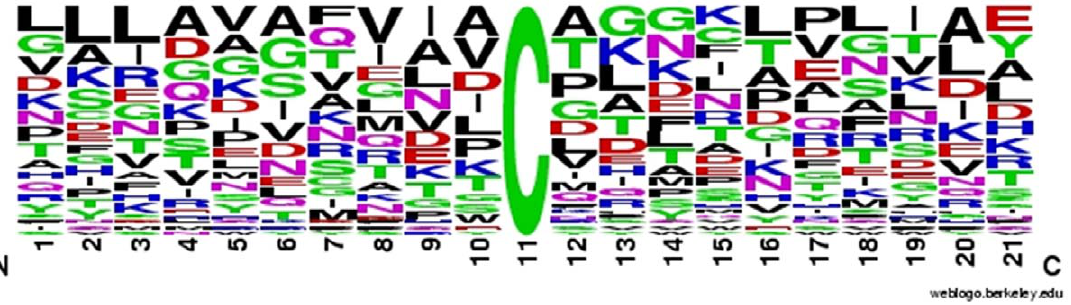
Figure 5. Frequency of amino acids surrounding S- nitrosylated cysteines in 42 sites mapped into structurally resolved domains from 24 different proteins. Hydrophobic residues are shown in black; charged residues in red and blue, respectively; and hydrophilic residues in magenta and green (for mixed-character residues).